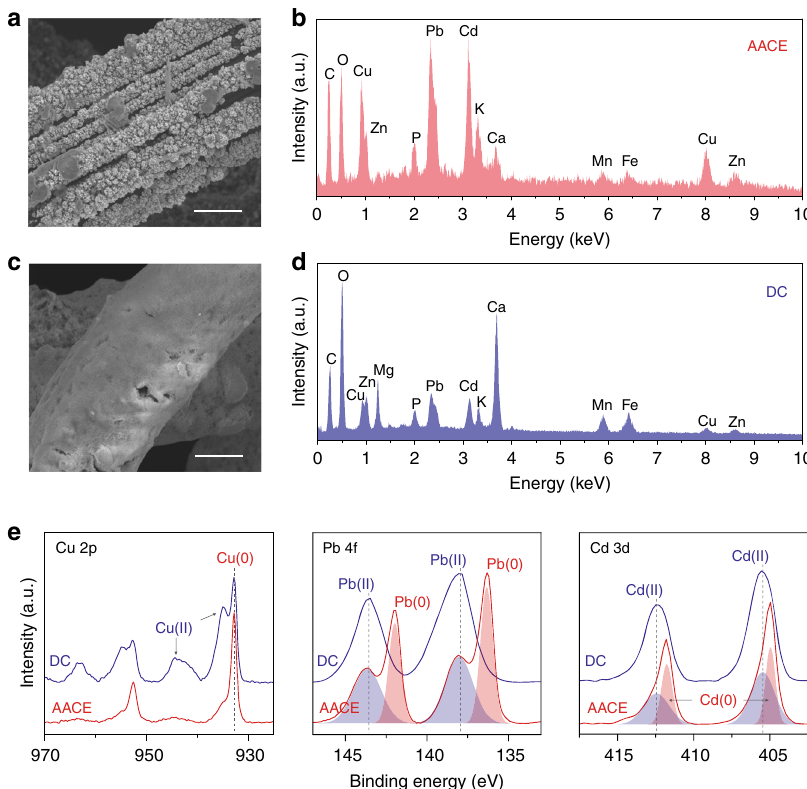
Fig. 3 Investigation of the AACE remediation mechanism. a SEM image showing the morphology of the heavy metal particles extracted by the AACE method. Scale bar, 5 μ m. b EDS showing the chemical nature of the extracted particles, where strong peaks of Cu, Pb, and Cd were found. c SEM image showing that the Ami-PC electrode was covered by a uniform shell when using a − 10 V DC in place of the asymmetrical alternating current for the fi ltration. Scale bar, 5 μ m. d EDS of the uniform shell showing a large accumulation of Ca and a small quantity of heavy metals. e Comparison of XPS of the heavy metal species extracted by the AACE method and the DC